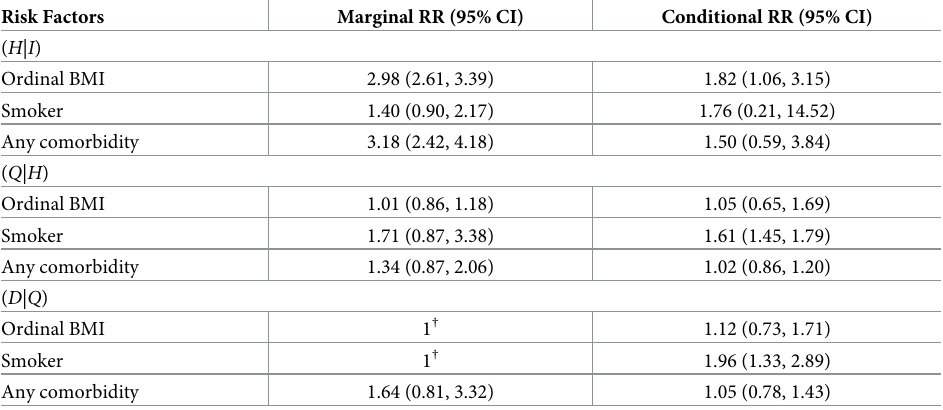
Table 1. The marginal relative risk of each stage of disease collected from published studies on COVID-19 and conditional relative risk estimated by the risk model for each risk factor on rates of hospitalization given infection, ( H | I ); ICU admission given hospitalization, ( Q | H ); and death given ICU admission, ( D | Q ) (95% credible interval). , and The reference group is individuals with no comorbidity, BMI < 30 kg m 2